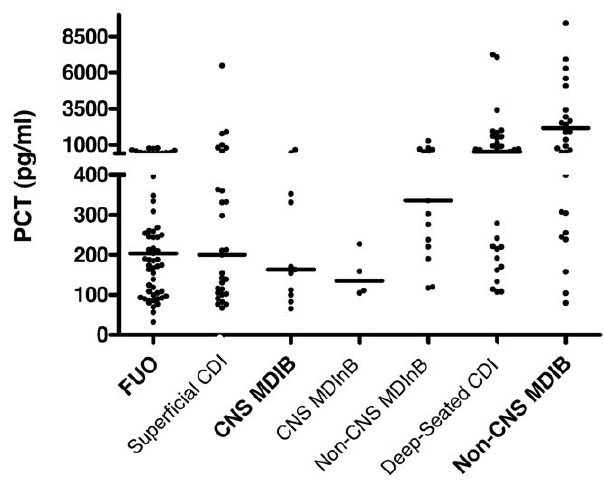
Figure 2. Individual PCT values on day 2 after onset of fever according to etiology of fever and localization of infection. Each point represents the PCT value in a single febrile episode. Horizontal bars represent median values in each group. MDIB=micro- biologically documented infections with bacteremia, MDInB=micro- biologically documented infections without bacteremia, CDI=clinically documented infections, FUO=fever of unknown origin, CNS=coagu- lase-negative staphylococci.